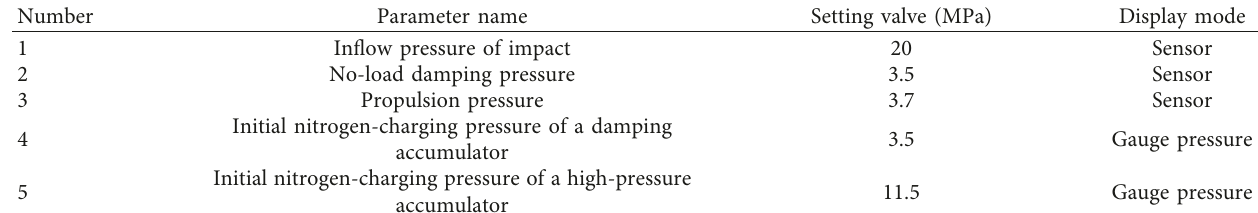
Table 4: Test initial data setting.